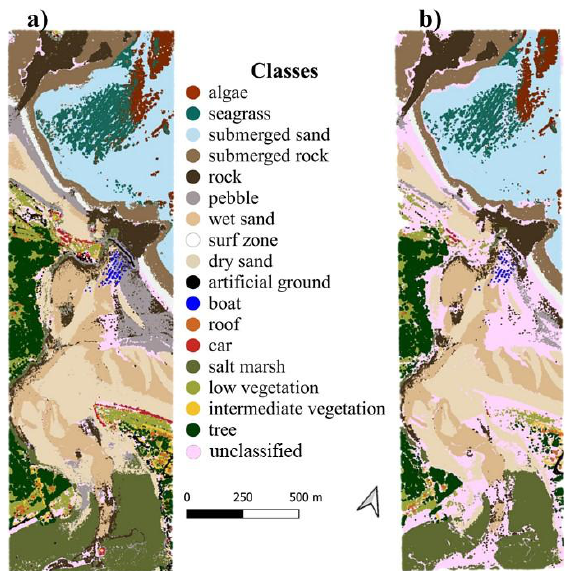
Figure 6. Land and sea covers map obtained at a) a 70% confidence level and b) a 90% confidence level.